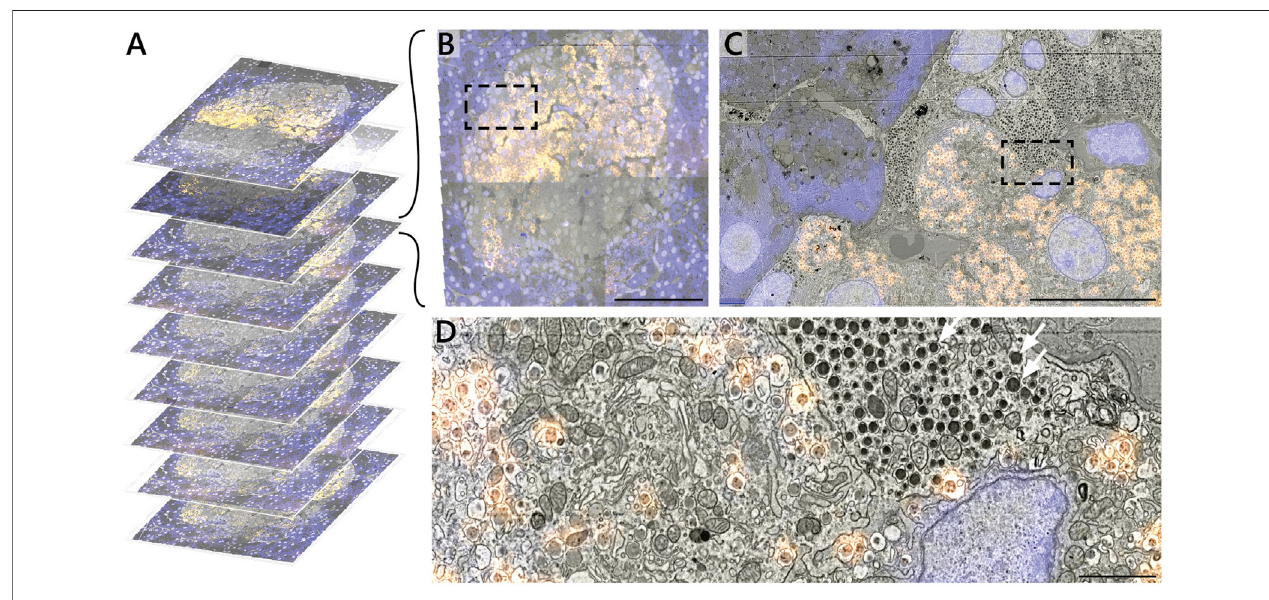
FIGURE5| Correlativereconstructionofninesections ofpancreas. (A) 2Dand3Dalignmentroutines arecombined toyieldaCLEMstackofnineserialsectionsof rat pancreas tissue. (B – D) CLEM imaging of the islet of Langerhans at varying spatial resolution. Hoechst (blue) and AF594 (orange) fl uorescence signals are superimposed onto the EM ultrastructure. The AF594 signal, in particular, facilitates recognition of insulin granules from e.g. non- fl uorescent glucagon granules (white arrows, D). Scale bars: (B) 50 μ m; (C) 5 μ m; (D) 1 μ m. Raw data at full resolution is available via Nanotomy.